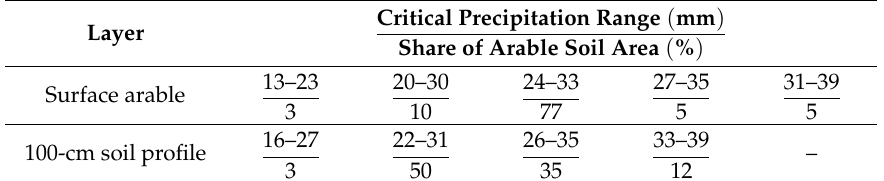
Table 5. Indicative area distribution of arable soils of Poland according to the ranges of critical precipitation preventing readily available soil water depletion in the growing period of arable crops.